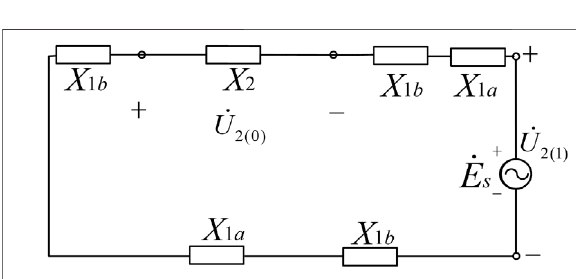
FIGURE 4 | Simpli fi ed equivalent sequence